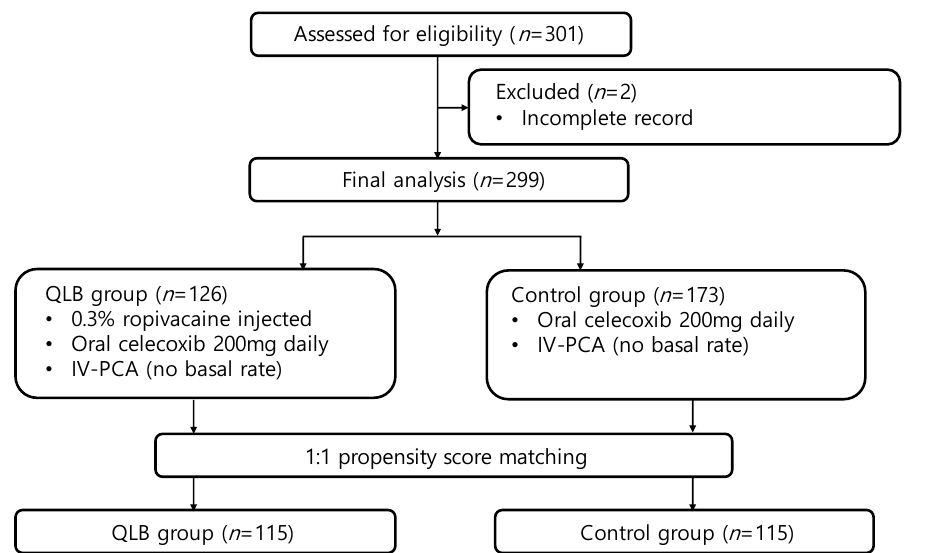
Figure 2. Flow chart of patient selection and propensity score-matching. QLB, quadratus lumborum block; PCA, patient-controlled analgesia; IV, intravenous.